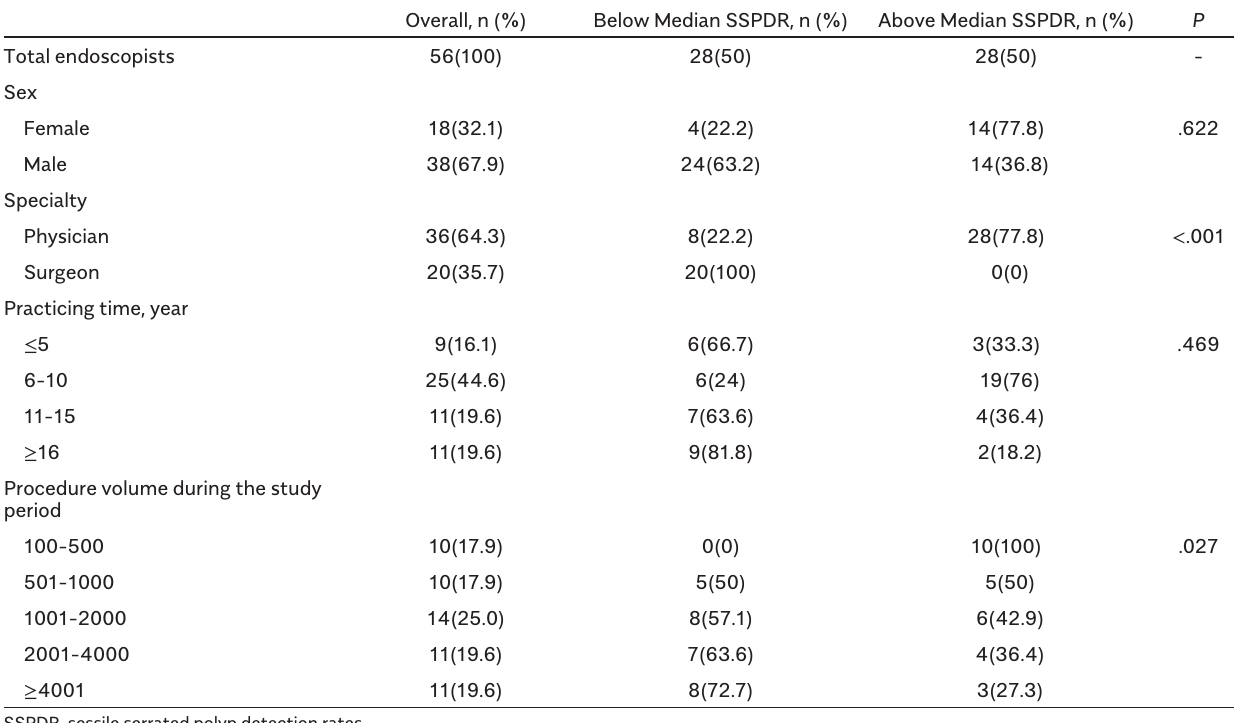
Table 3. Endoscopist Factors Associated with Sessile Serrated Polyp Detection Rates (SSPDR) Above and Below the Median Rate Overall, n (%) Below Median SSPDR, n (%) Above Median SSPDR, n